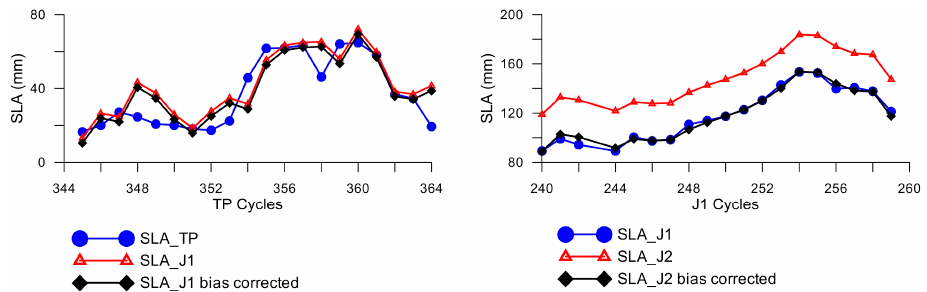
Figure 21. Mean SLA values (mm) for the cycles of the TOPEX/Poseidon–Jason-1 tandem mission ( left ) and for the Jason-1–Jason-2 tandem mission ( right ). Jason-1 values corrected for the (TP, J1) bias and J2 values corrected for the (J1, J2) bias are also shown.